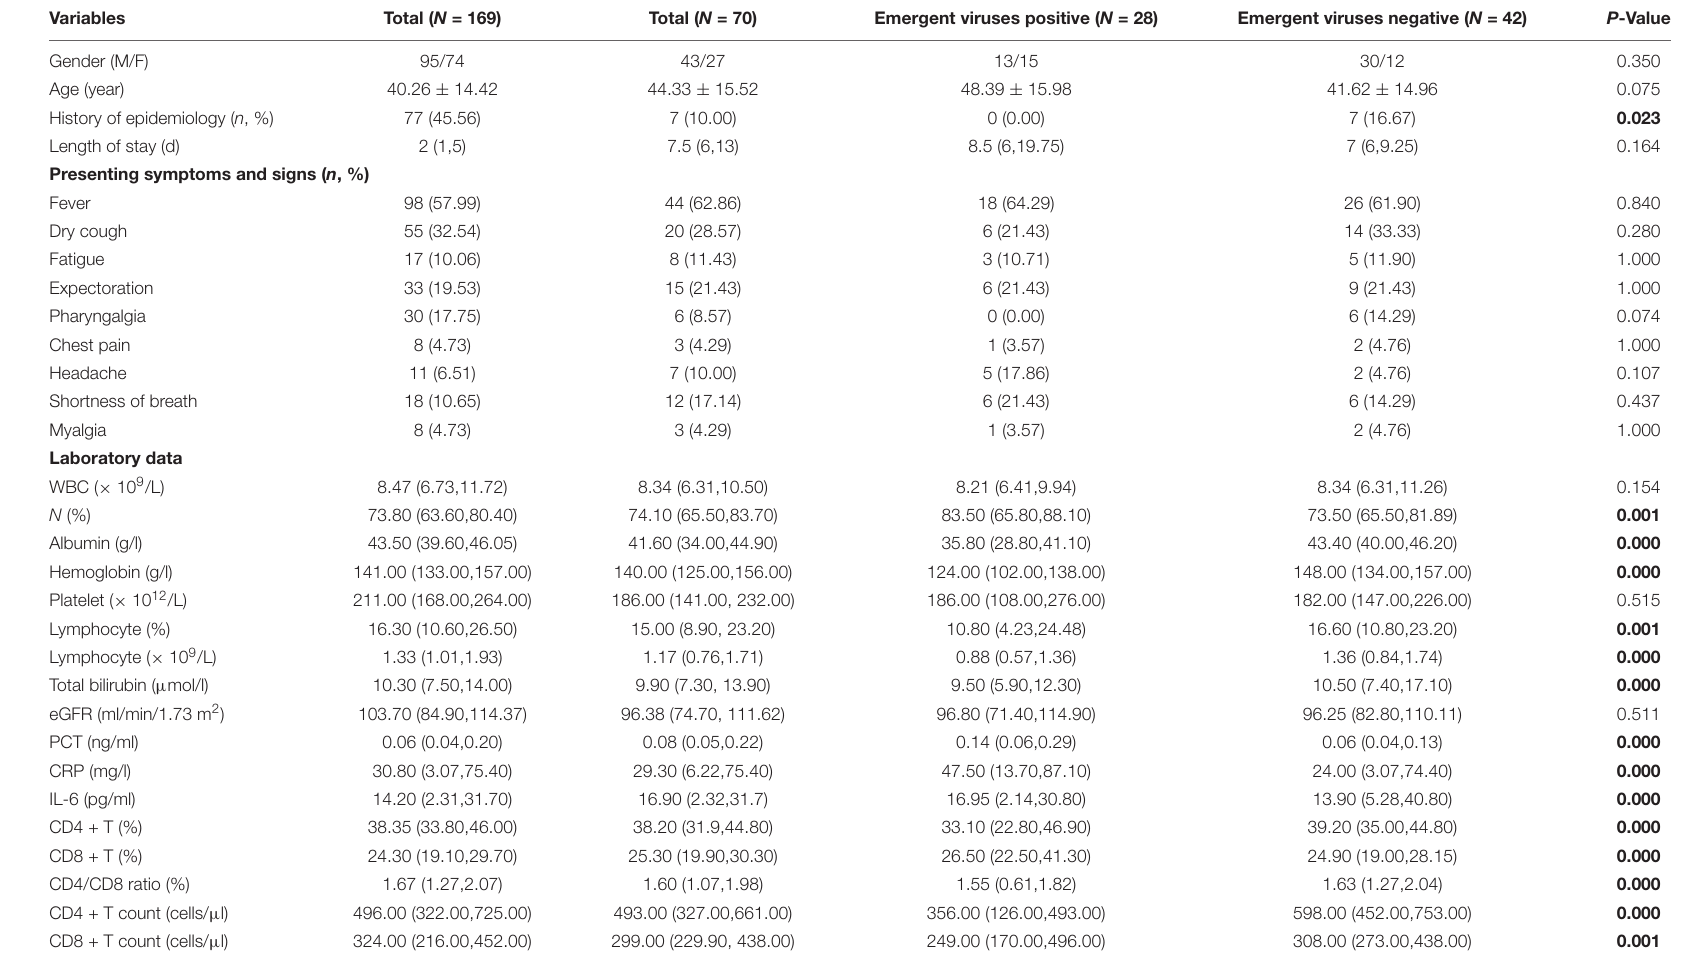
TABLE 1 | Demographic and clinical characteristics in SARS-CoV-2-Negative community acquired pneumonia patients.